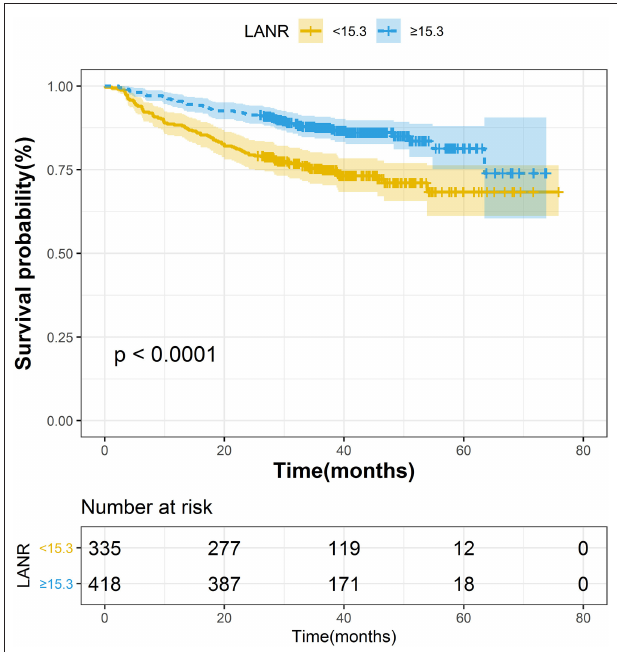
FIGURE 1 | The Kaplan–Meier curves for overall survival of colorectal cancer patients based on LANR.